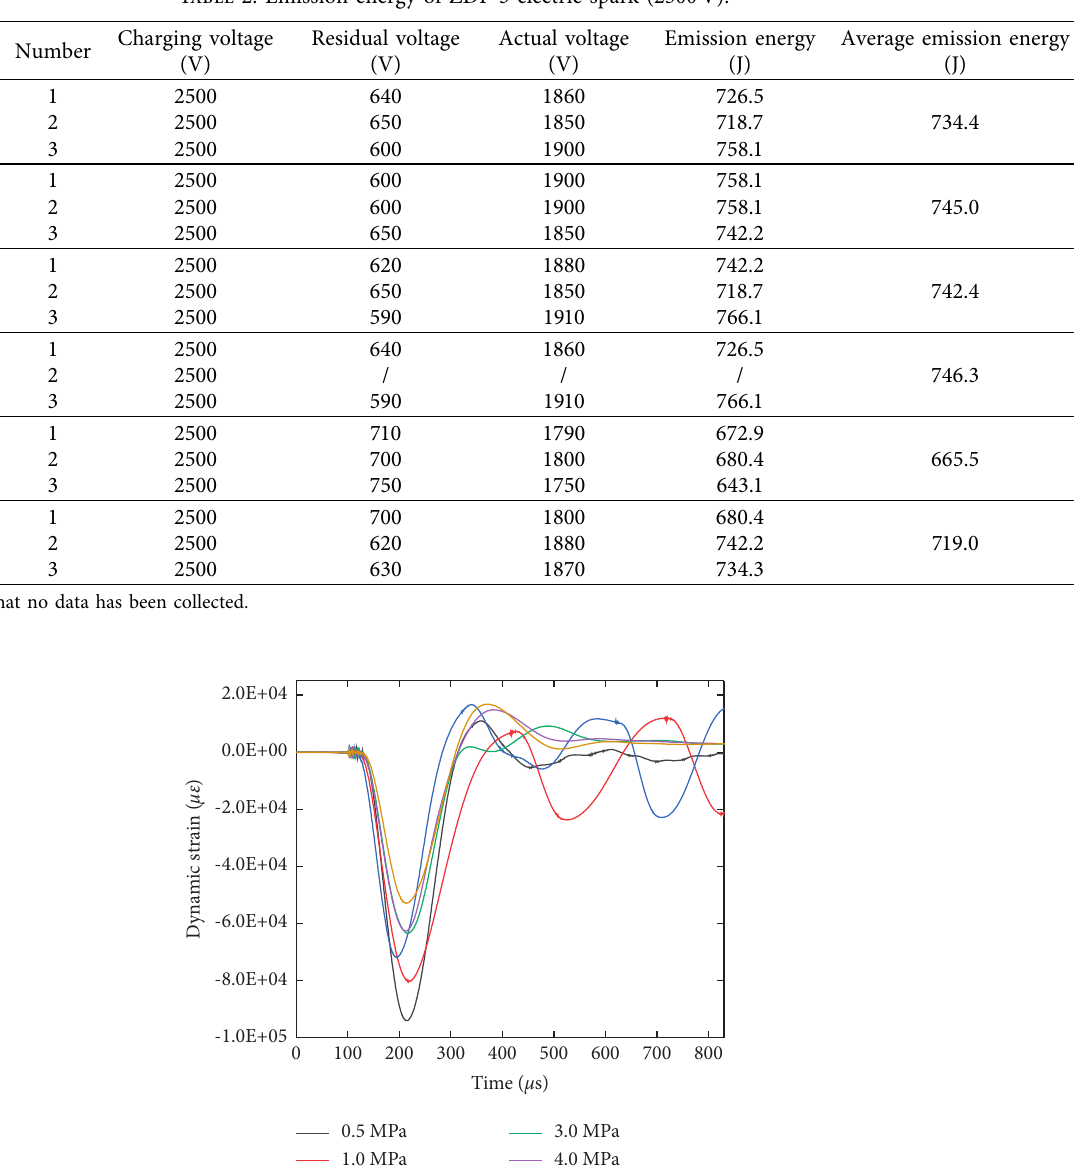
Table 2: Emission energy of ZDF-3 electric spark (2500 V).